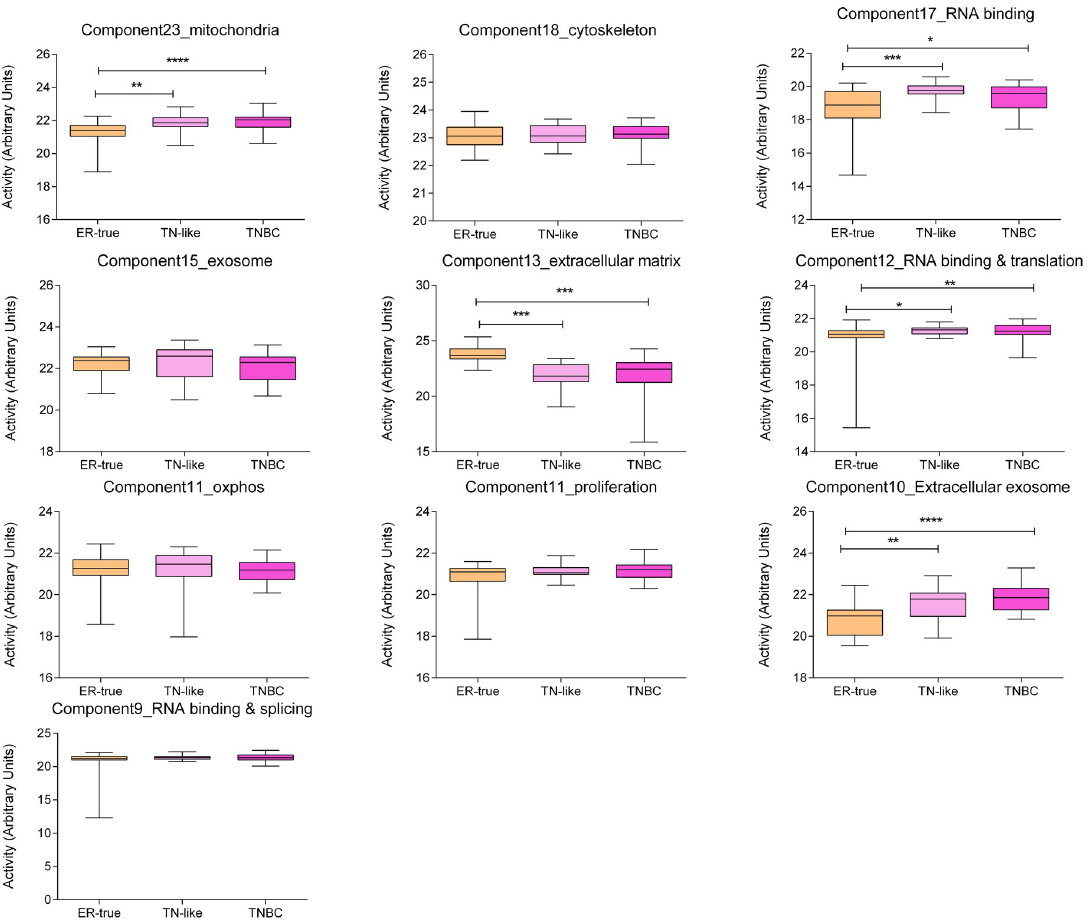
Fig 1. Component activity measurements for ER-true, TN-like and TNBC